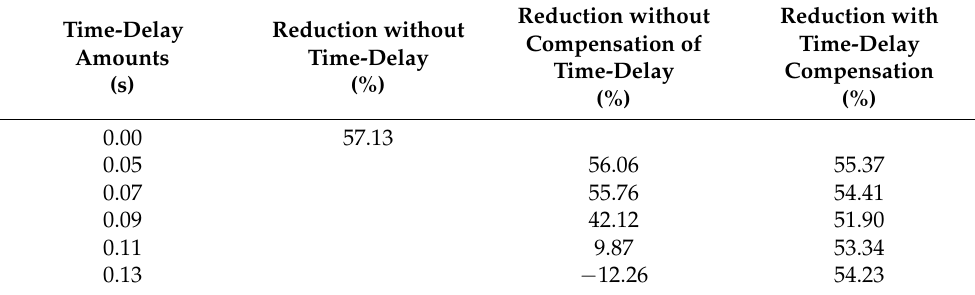
Table 2. Response reduction at mid-span of three control strategies under free vibration.